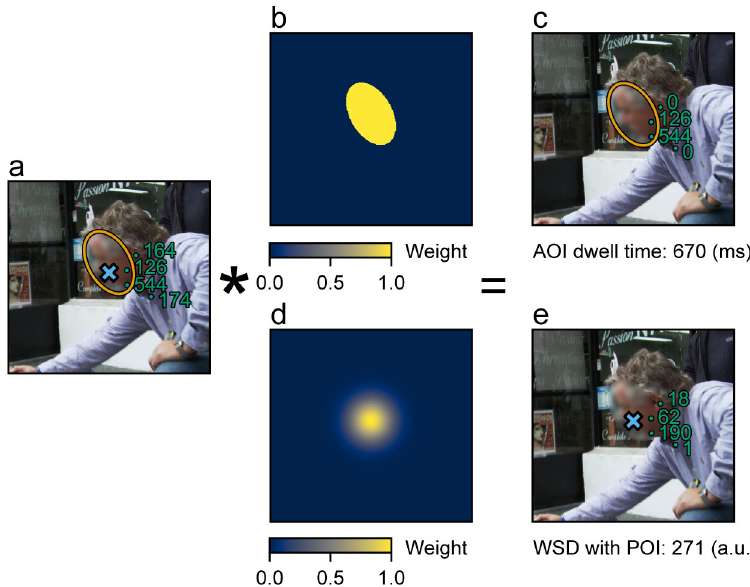
Fig 1. Example of AOI dwell time and WSD calculation. a) An example of a participant’s fixations (Bluish-green dots where bluish-green numbers denote the fixation duration for each fixation), AOI (orange ellipse) definition, and POI (sky blue X) definition are shown on a subset of an exemplar image. Although we present a partially-blurred image here to protect privacy, the participants saw real, unblurred images in the experiment. b) The uniform kernel weights used for AOI dwell time calculations. c) An example of AOI dwell time calculation. d) The Gaussian kernel weights used for the WSD calculation. e) Example of WSD calculation. Note that the original fixation durations have been reweighted based on their proximity to the